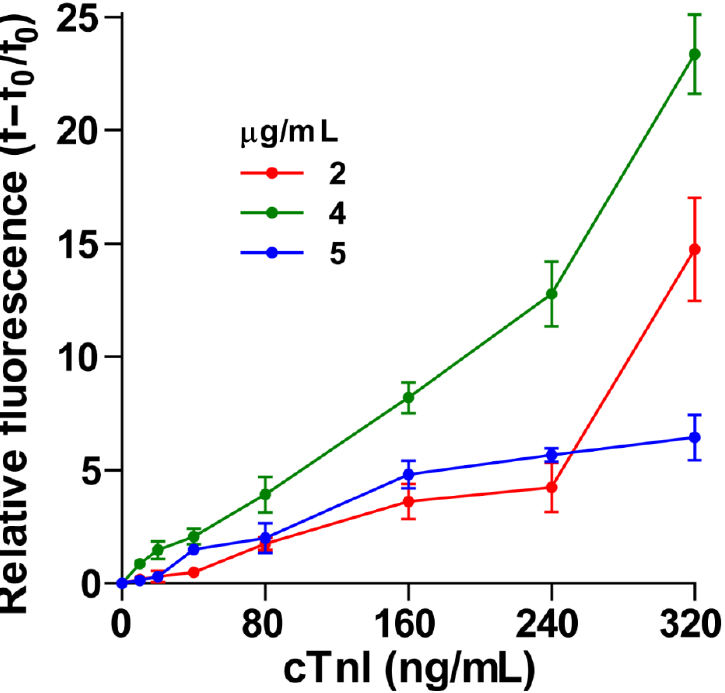
Figure 4. Effect of Ab 1 (capture antibody) concentration on cTnI assay. The relative emission at different levels of cTnI is plotted for three different concentrations of capturing antibodies (Anti 9705- 2, 4, and 5 µg/mL) keeping other assay parameters the same (cTnI levels 0 ‒ 320 ng/mL, 2 µg/mL of SA, 2 µg/mL of Biotin ‒ Ab 2 , and 1:100 diluted biotin calcein liposomes). The error bars show the standard deviation of values for the triplicate readings obtained for three different assay experiments. (Two-way ANOVA test showed that there is statistically significant difference ( p < 0.05) between 4 assay and the other two assays ( p < 0.001 and p < 0.001), but there is statistically insignificant difference ( p = 0.069) between 2 and 5 assays).